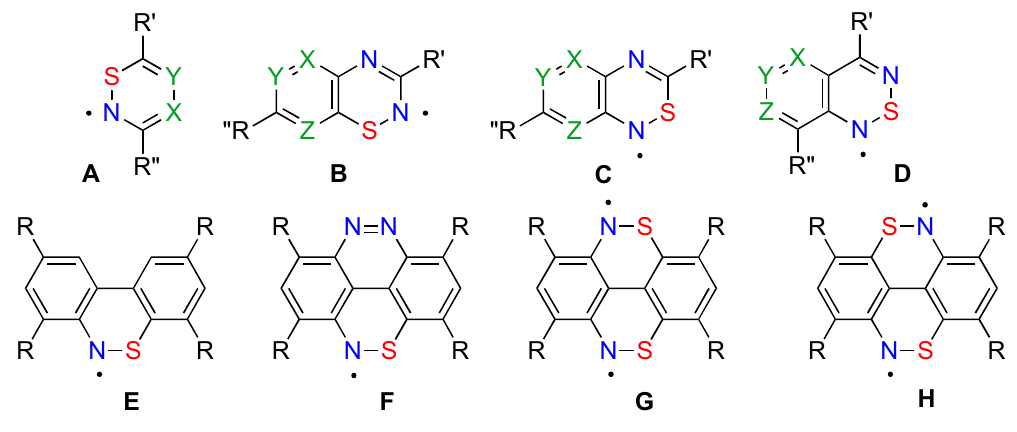
Figure 1 . Potential structural elements for liquid crystalline radicals. X, Y, Z = N, CH, C-F, C-Cl; R = poly[alkyl(oxy)]phenyl; R', R" = alkyl(oxy), cycloalkyl, aryl.